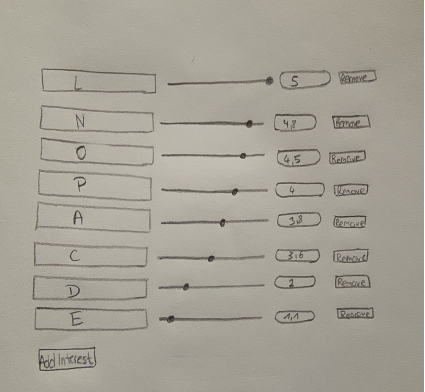
Figure 8. Scrutunize : Visualizations for editing the user profile. For the goal Socialize , a Venn diagram and a butterfly chart were proposed for the comparison of two users with similar profiles. The common interests would be in the middle of the Venn diagram, while in the butterfly chart, the profiles would be next to each other. To realize the idea of ’authors who influenced the user and are most influenced by the user’, we proposed a node-link diagram consisting of the user, who is represented via an icon, in the middle. To the left, three other user icons with arrows going to the middle user were shown. Three outgoing arrows from the middle user lead to three further user icons on the right. This graph could represent which authors influenced the user in the middle the most, and which authors were influenced by them the most (Figure 9).